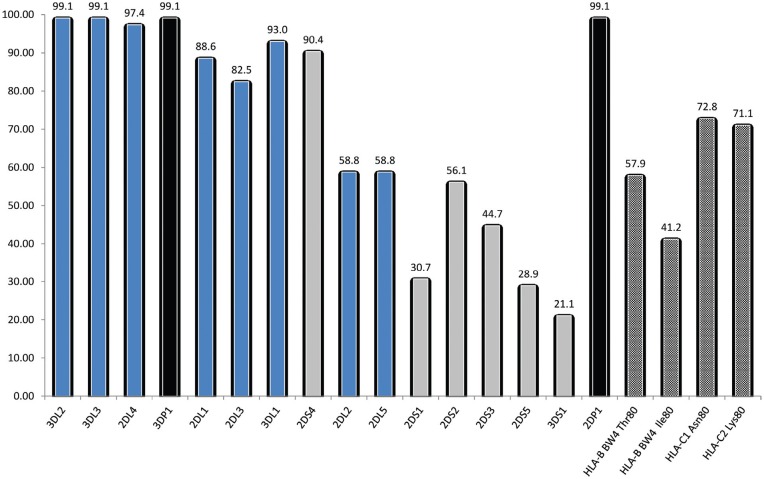
Distribution of observed frequencies of KIR genes and their HLA ligands among the studied Saudi population. Blue = inhibitory, grey = activating, black = pseudogenes, hatched = HLA ligands.